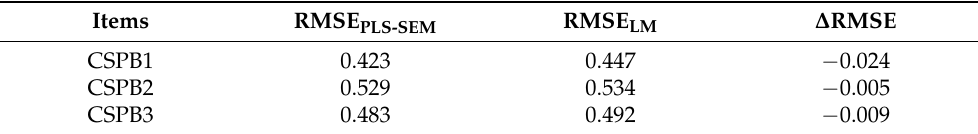
Table 4. PLS predict assessment of the manifest variable CPB.